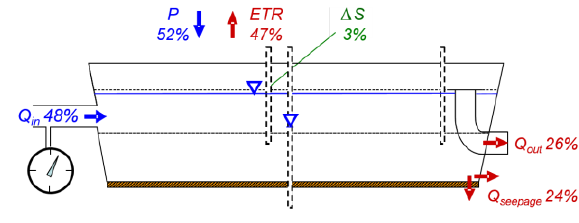
Figure 7. Water balance components of the Sphagnum farming trial (in %) for the hydrological year 2013 (November 2012–October 2013).